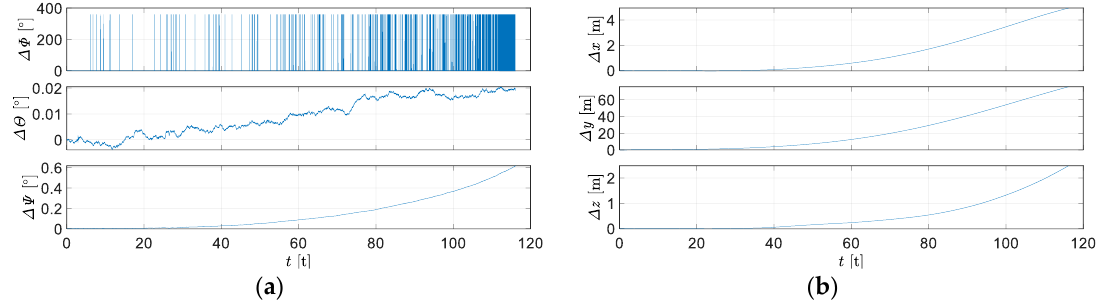
Figure 21. INS errors ( a ) orientation ( b ) position (launch elevation angle 50 ◦ Figure 21 . INS errors (a) orientation (b) position (launch elevation angle 50°).